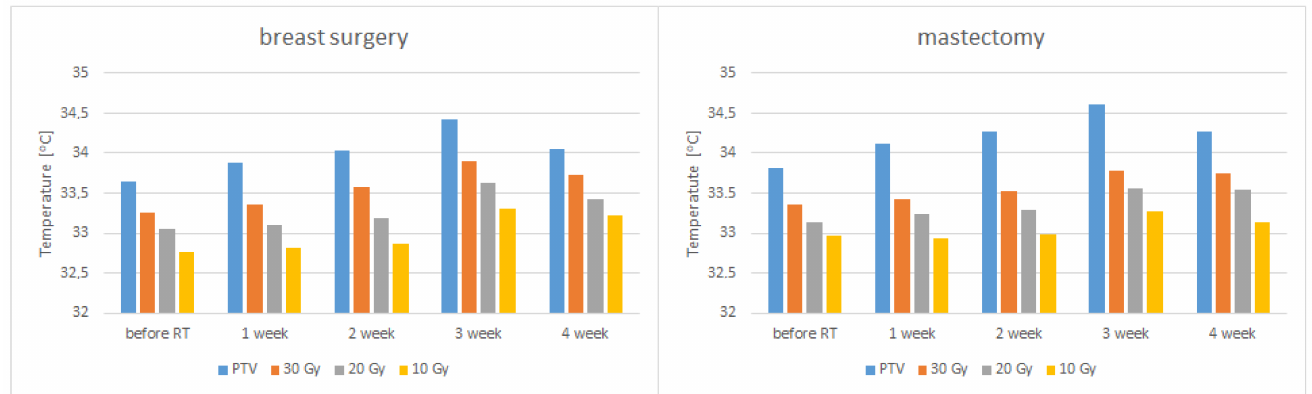
Figure 6. Mean temperatures of patients in the group after conserving surgery and after mastectomy in the area of PTV and